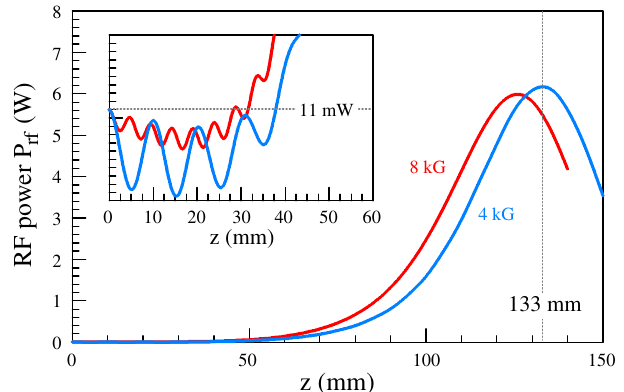
FIG. 16. (Color) Dependence of rf power P on axial distance z rf for 4-kG and 8-kG focusing magnetic fields. The input rf power is increased to 11 mW while the injected beam is the same as in Fig. 15. The rf power for the beam focused by a 4-kG magnetic field fluctuates more deeply in the initial low power region.